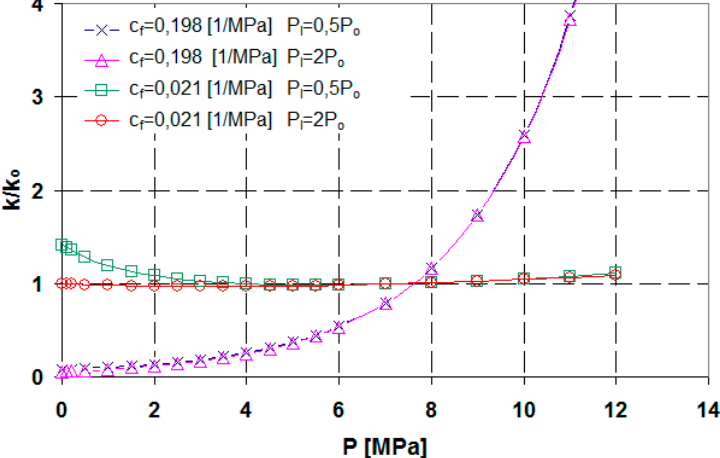
Figure 9. Changes in the Mannville Group coal permeability depending on the extreme values of ε l . 339 Similar simulations were performed in relation to the changes in P l . The values of P L were 340